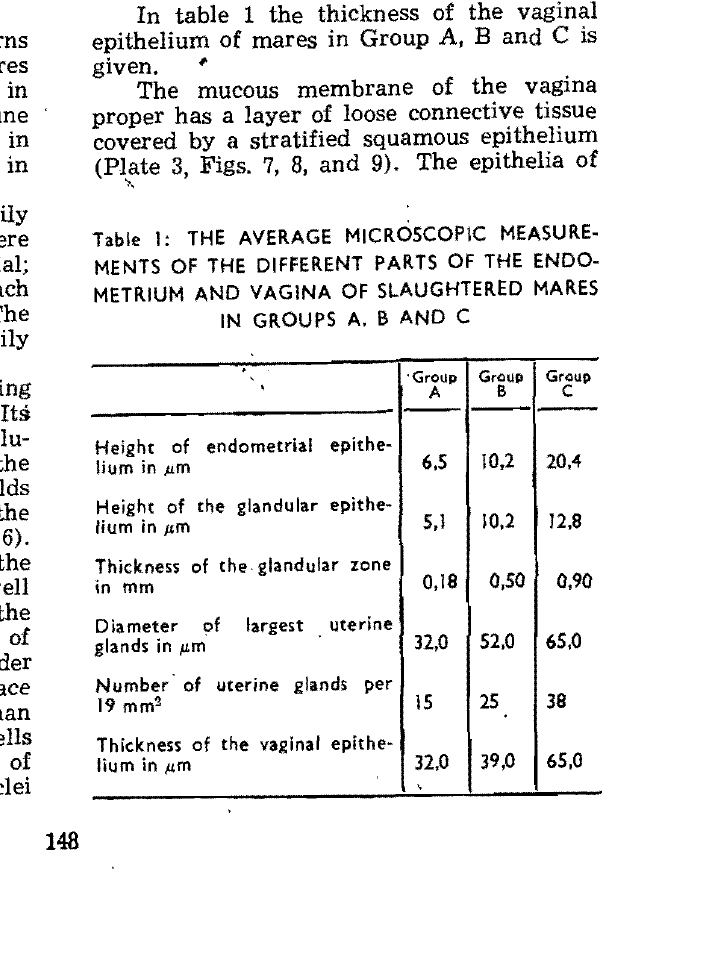
Table 1: THE AVERAGE MICROSCOPIC MEASURE MENTS OF THE DIFFERENT PARTS OF THE ENDO METRIUM AND VAGINA OF SLAUGHTERED MARES IN GROUPS A. BAND